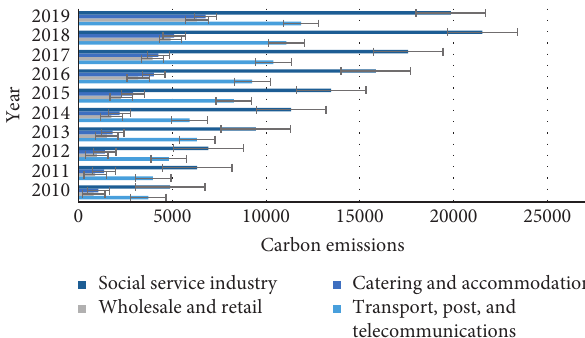
Figure 3: Analysis and comparison of carbon emission of China’s overall and regional tourism growth rate from 2010 to